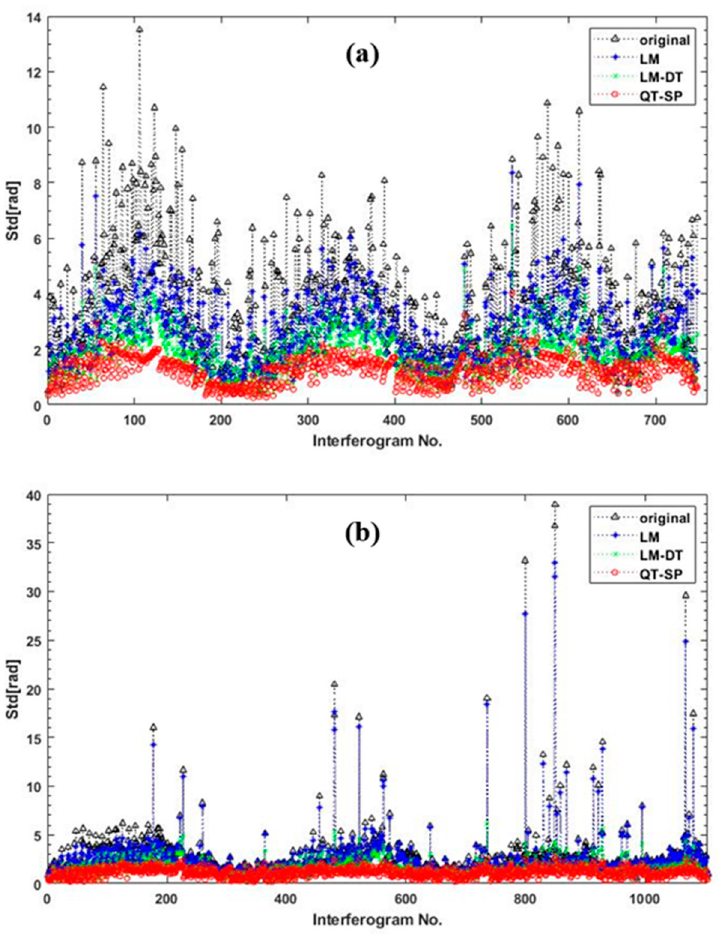
Figure A1. The STD values of all original unwrapped phases and the ones corrected by three methods for ( a ) frame 120 and ( b ) frame 115 Sentinel − 1A interferograms.